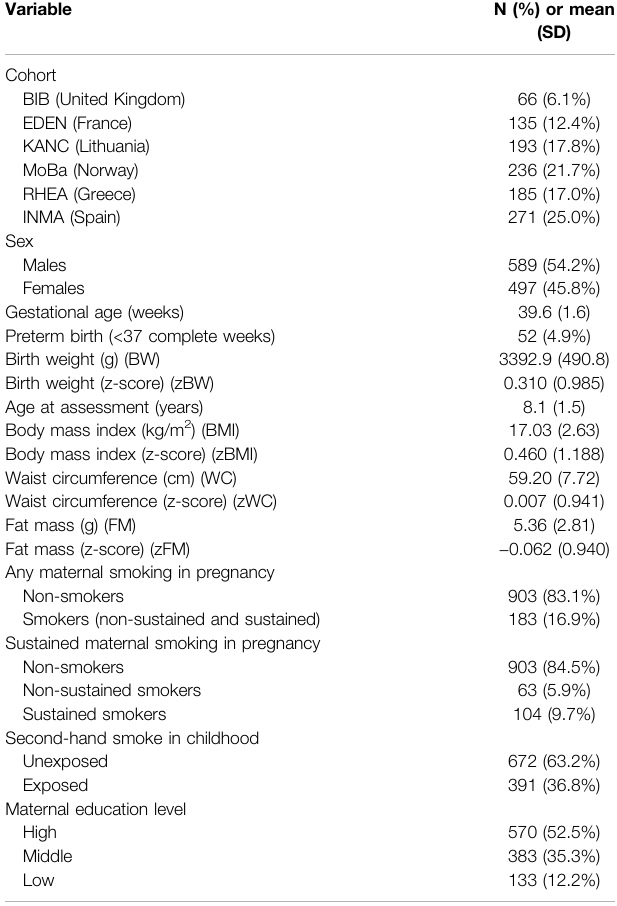
TABLE 1 | Descriptive of the HELIX children (N =